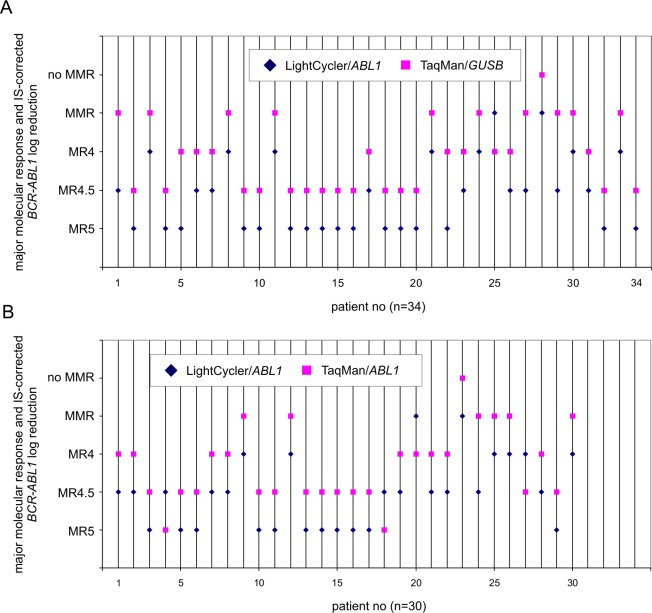
Diagnostic outcome.A. Assay-related shifts (n = 34) in the diagnostic outcome of 92 CML patient samples were analyzed with the TM/GUSB combination (pink squares) instead of LC/ABL1 combination (blue diamonds). B. Assay-related shifts (n = 30) in the diagnostic outcome of 92 CML patient samples were analyzed with the TM/ABL1 combination (pink squares) instead of LC/ABL1 combination (blue diamonds). Abbreviations: MMR, major molecular response; MR4 indicates ≤ 4-log reduction (BCR-ABL1 IS ≤ 0.01%), MR4.5 indicates ≤ 4.5-log reduction (BCR-ABL1 IS ≤ 0.0032%), and MR5 indicates ≤ 5-log reduction (BCR-ABL1 IS ≤ 0.001%). The prerequisite for valid calculation of major responses (log reduction) is a sufficient RNA quality as given by the absolute copy numbers of housekeeping gene GUSB.